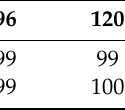
Figure 5. Comparison of curing degrees as represented by the tensile strength and conversion rate of epoxy groups: ( a ) increase curves for both curing degrees; ( b ) polynomial fitting curve for conversion rate of epoxy groups, and ( c ) correlation curve between two curing degrees. Table 5. Curing degrees at different curing times as characterized by the epoxy group conversion rate and tensile strength.